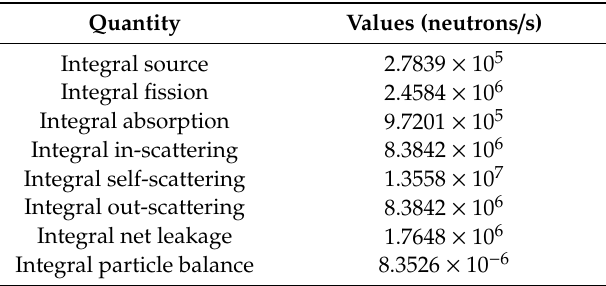
Table 3. Nominal values of the source parameters for the PERP benchmark [10].